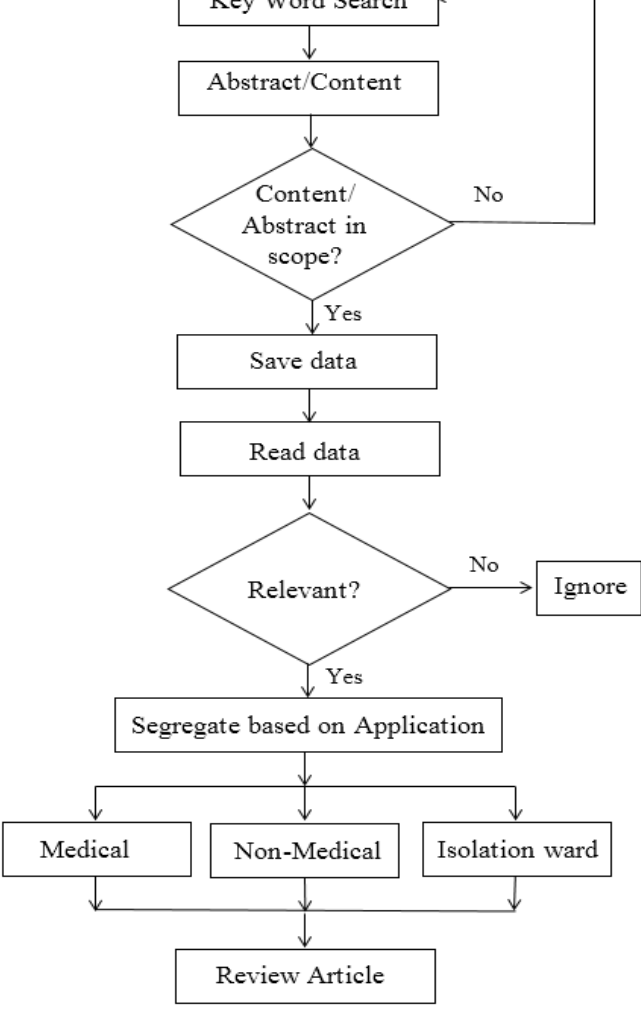
Figure 1. Detailed flow chart of the methodology followed.